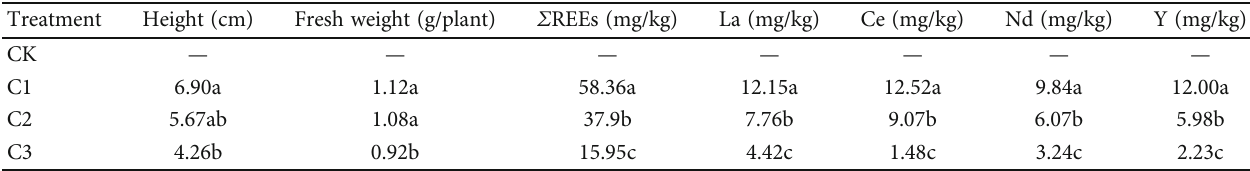
Table 3: Growth characteristics and rare earth element content of Chinese cabbage grown in rare earth mine tailings conditioned with a combination of fertilizer and lime.